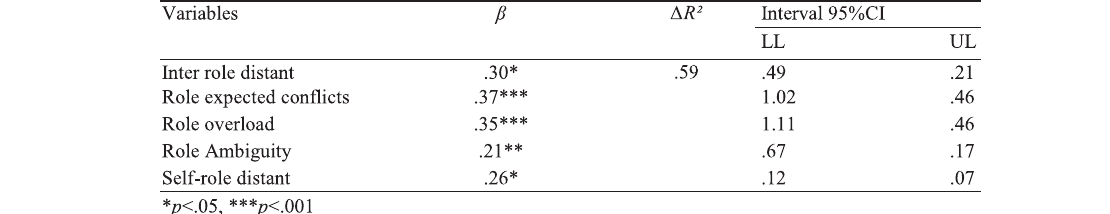
revealed that there is significant impact of occupational role stress on life satisfaction F (1,198) =74.47, p<.001. This model explained 38% of variance in the dependent variable. Table 3 Multiple regression analysis showing the impact of subscales of occupational stress on life satisfaction (N=120)